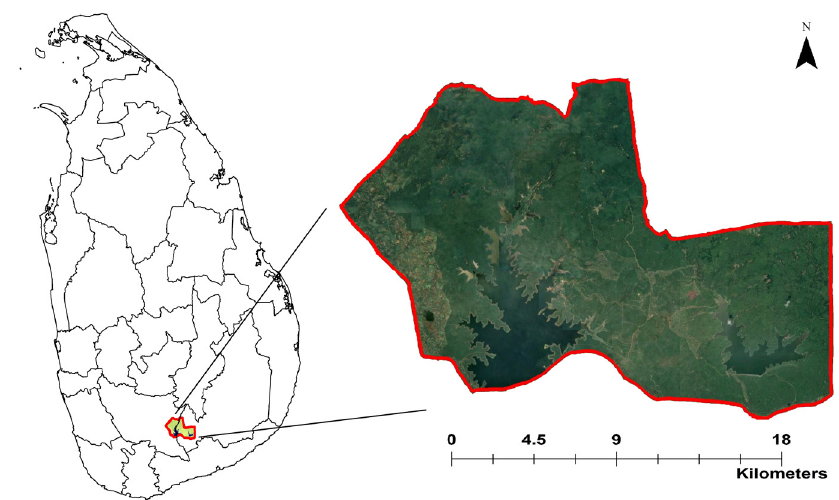
Figure 1: The Udawalawe National Park (right) and the map of Sri Lanka showing its location